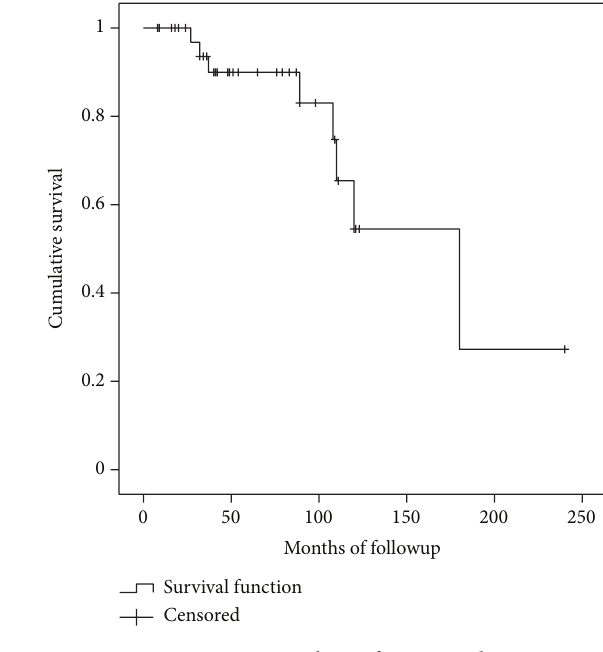
Figure 5: Allograft survival. Figure 6: Articular surface